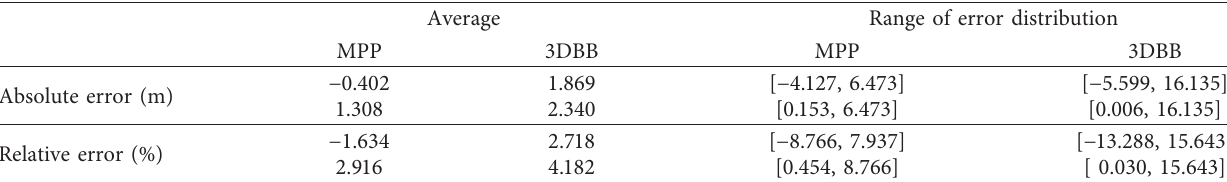
Figure 18: Comparison of the space headway calculated by the different algorithms with the ground truth. In this figure, “error” means absolute error. The lengths of the bars represent the values of the errors. One end of the bar is the GT, and the other end is the estimated space headway. Table 6: Errors of the space headway by different algorithms. The first row for each item contains the results of the errors considering the signs and the results of absolute values of errors are in the second